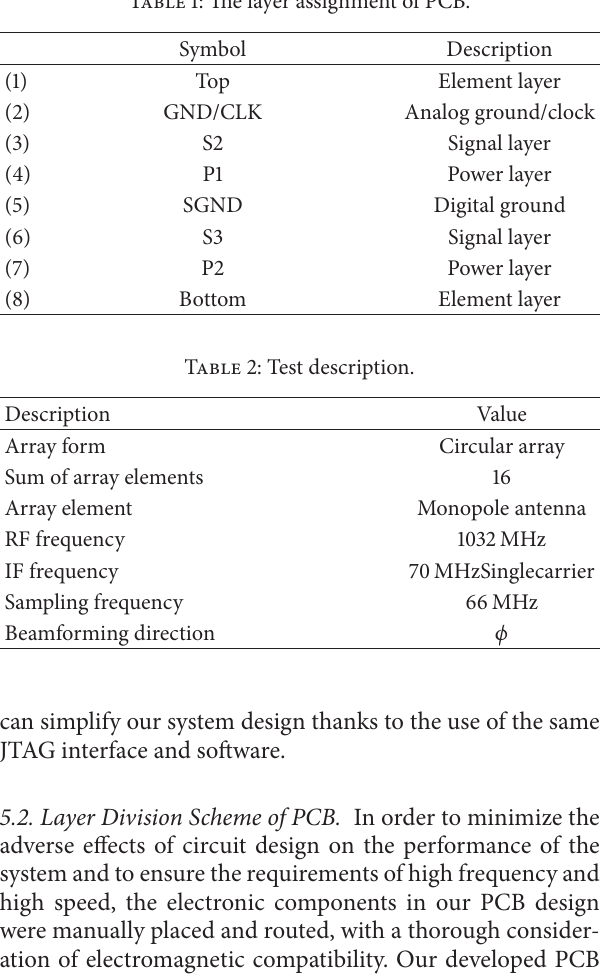
Table 1: The layer assignment of PCB.